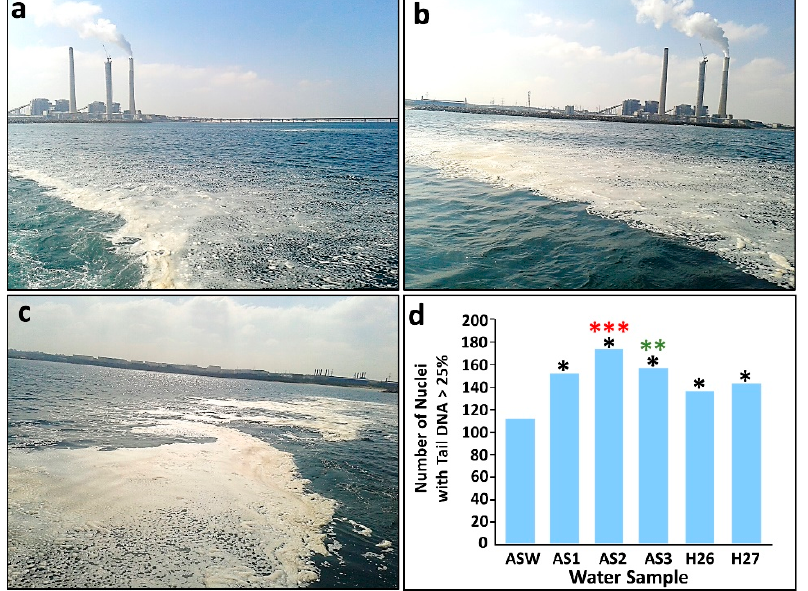
Figure 3. ( a – c ) Images of unknown-origin spill observed near the Ashkelon desalination plant on 17.8.2014. ( d ) Genotoxicity tested by comet assay at sites within the spill area and the remote H26 and H27 sites. A total of 300 nuclei were analyzed per site/treatment. Significant differences: * —significant result relative to ASW control; ** —H26 vs. other field samples; *** —field samples vs. H26 and H27.